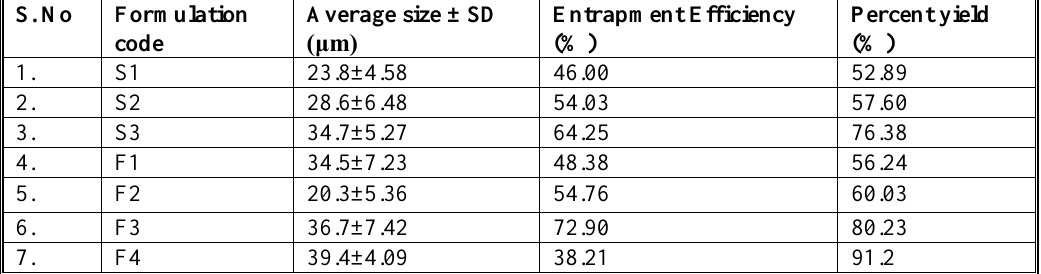
Mean ± SD Where n = 3 Table 4. In vitro release data of acyclovir microspheres (2 and 4 %w/v Calcium chloride)